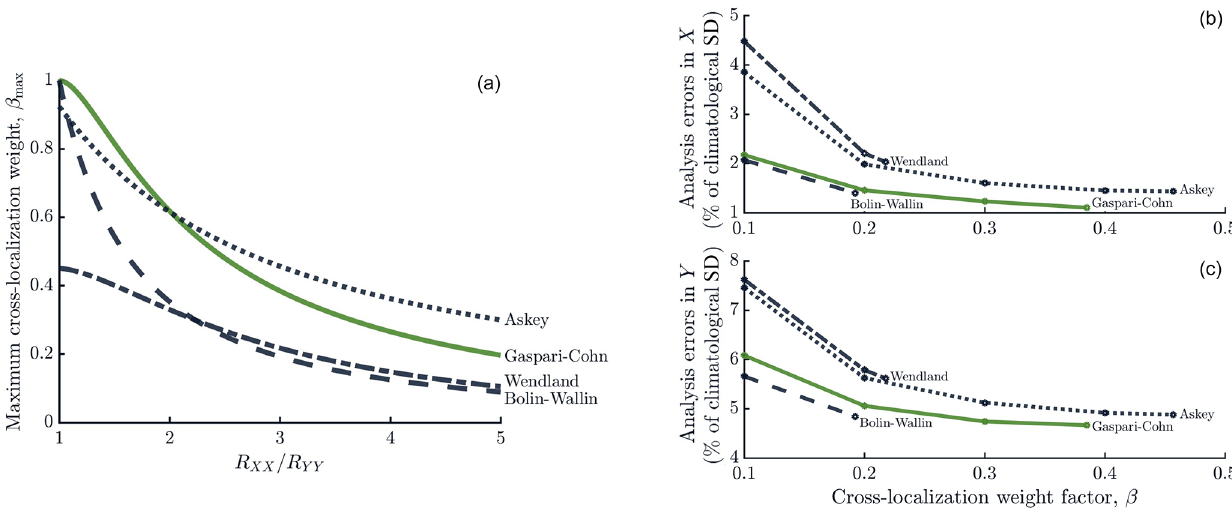
Figure B3. (a) Maximum cross-localization weight factor as a function of R XX /R YY . (b, c) Average analysis errors are shown on the y axis for different multivariate functions. The top (bottom) plot shows analysis errors for the X ( Y ) process. For all functions, as the cross- localization weight factor increases, the analysis errors decrease. Analysis errors are calculated as RMS deviations from the truth and are scaled by the climatological standard deviation of the associated process.